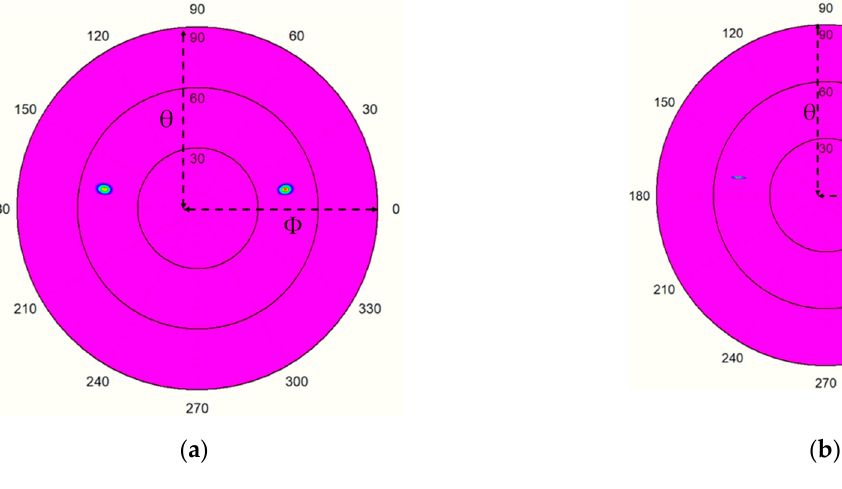
Figure 7. The FFP intensity is calculated using FDTD for 32 antennas. ( a ) The OPA main beams of a conventional single-width combination without a SR grating. ( b ) The primary beam intensity of a chirped FBG built with SR in OPA steering.